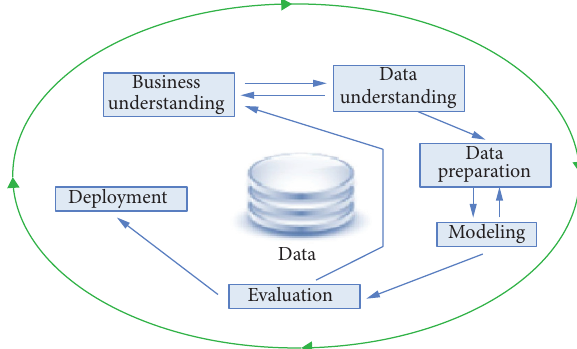
Figure 1: The cross-industry standard process for data mining (CRISP-DM) [20].